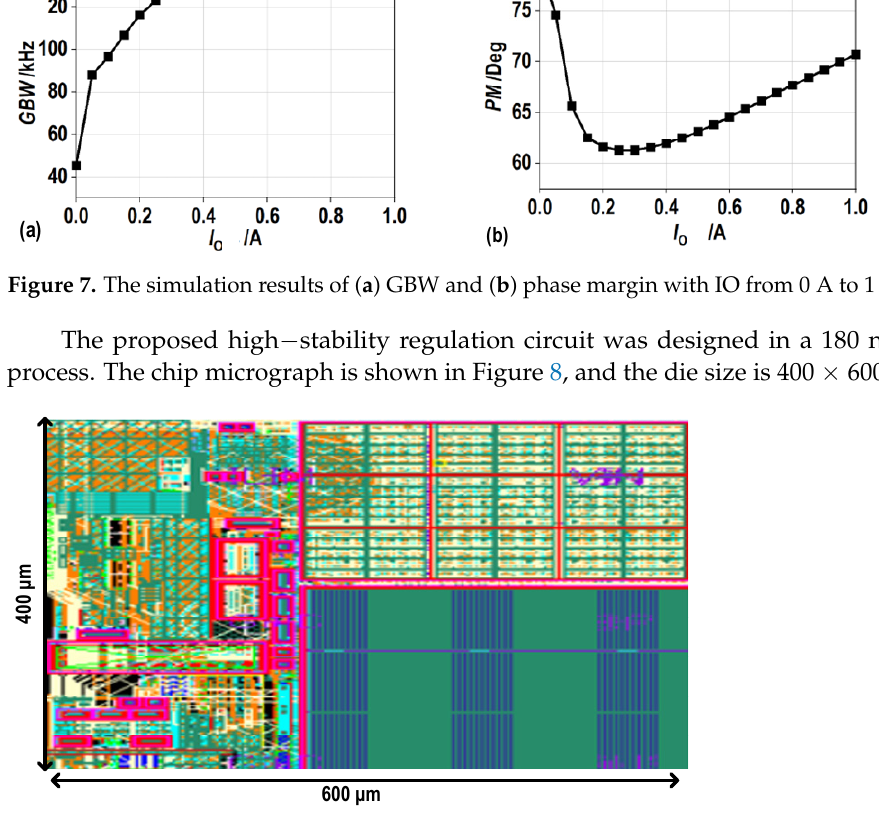
Figure 8. The chip micrograph.